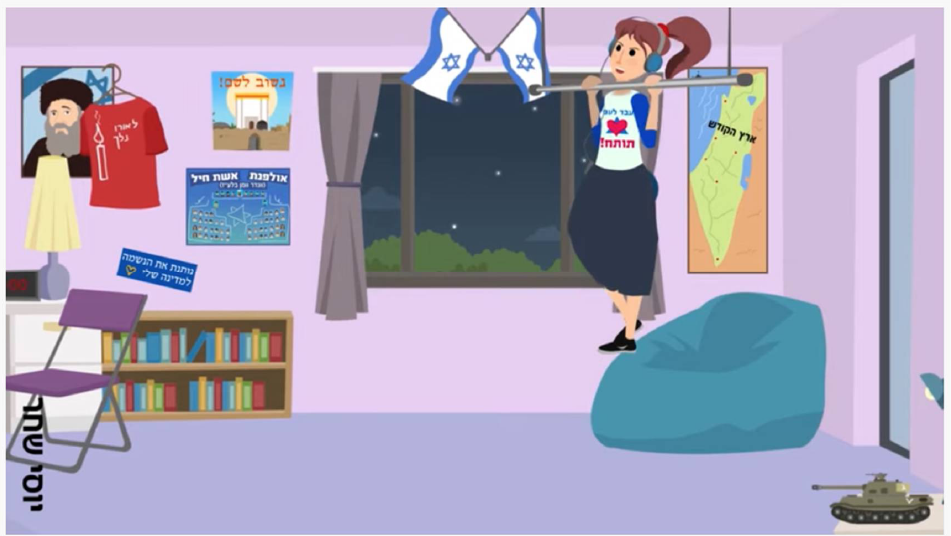
Figure 6. ‘To choose correctly’ ( October